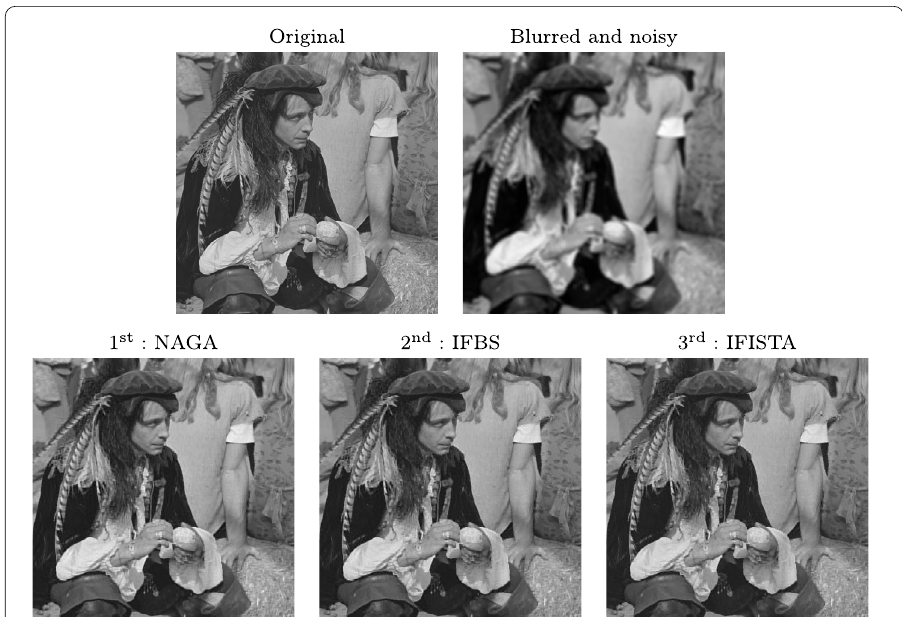
Figure 11 Top three fast convergence with good performance for deblurring of Pirate